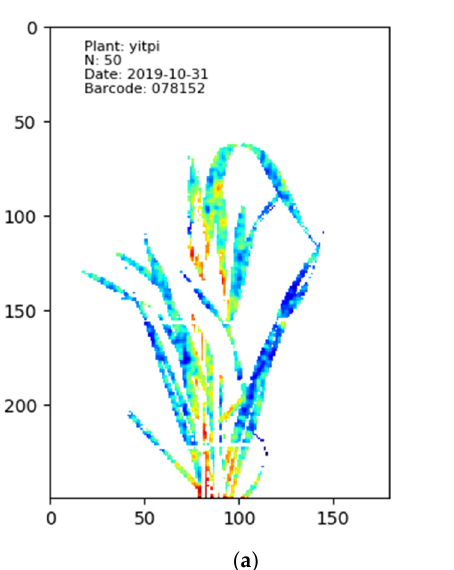
( a ) ( b ) Figure A6. The N distribution maps of Yitpi on different days w ith the same N treatments. Image ( a ) shows the plant on 17 October when it was still young. In the different parts, most of the pixels show orange or green colour, indicating sufficient N was roughly evenly distributed in the leaves. In contrast, image ( b ) shows the same plant at an older stage on 1 December. Because the N was insufficient to supply all of the leaves, some old leave and the tips of young leaves lacked enough N, changing to blue. References 1.